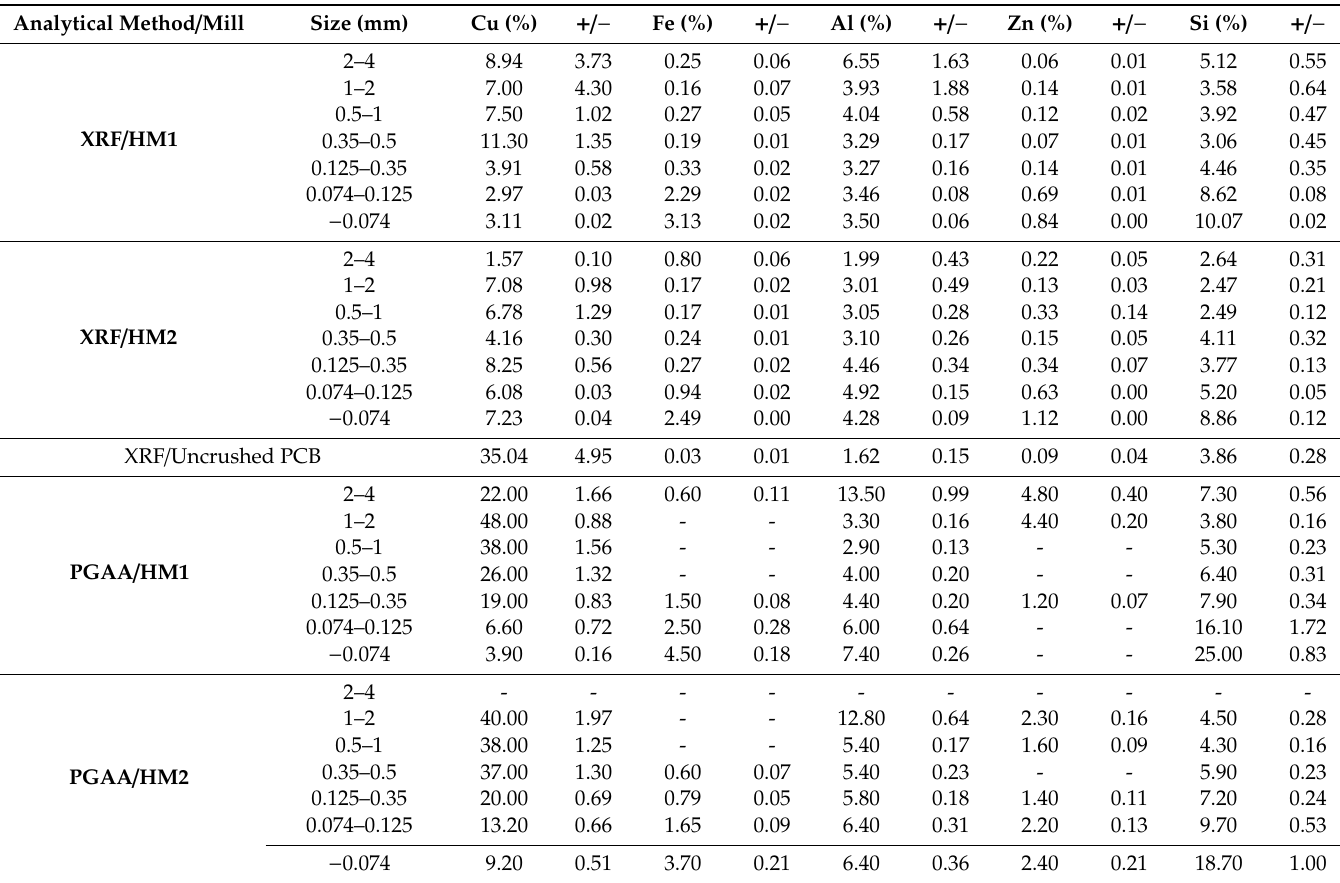
Table 1. Concentrations of the major elements identified by the portable X-Ray Fluorescence (XRF) and prompt gamma ray neutron activation analysis (PGAA). The analysis is divided by size fractions and for the di ff erent hammer mills used (HM1 and HM2). The metal (wt.%) on the uncrushed printed circuit boards (PCBs) is given at the bottom of the XRF analysis. The 95% confidence interval and absolute uncertainties for XRF and PGAA respectively are also given next to each metal% under the symbol of +/ − . For the blank spaces, the referred element was not reported in the composition for that size fraction, while the dashed lines indicate that no experiment was performed due to the absence of enough material by fine grinding (2–4 mm PGAA